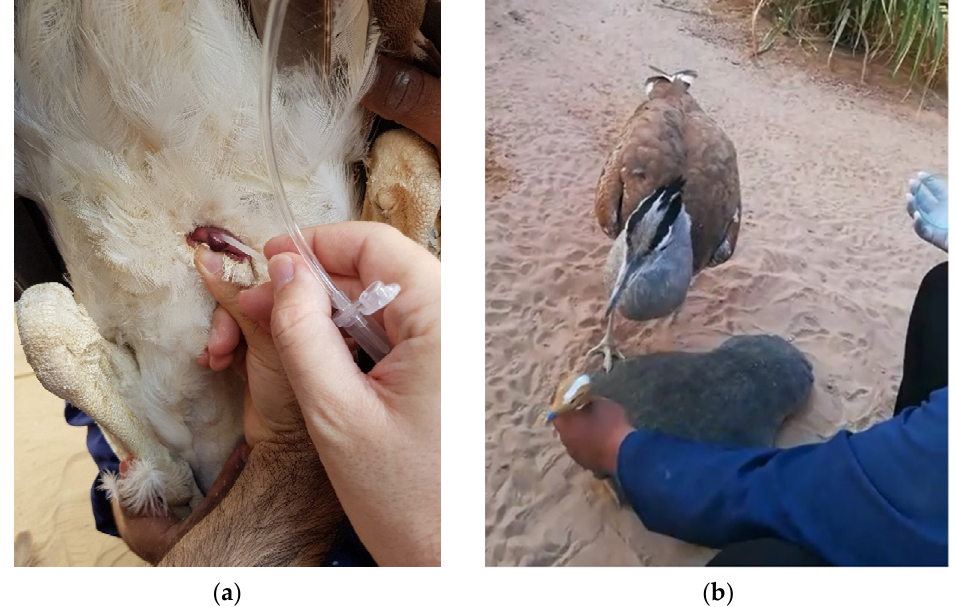
Figure A5. Semen collection attempts on Arabian bustard males using ( a ) the stroking method and ( b ) a dummy female.